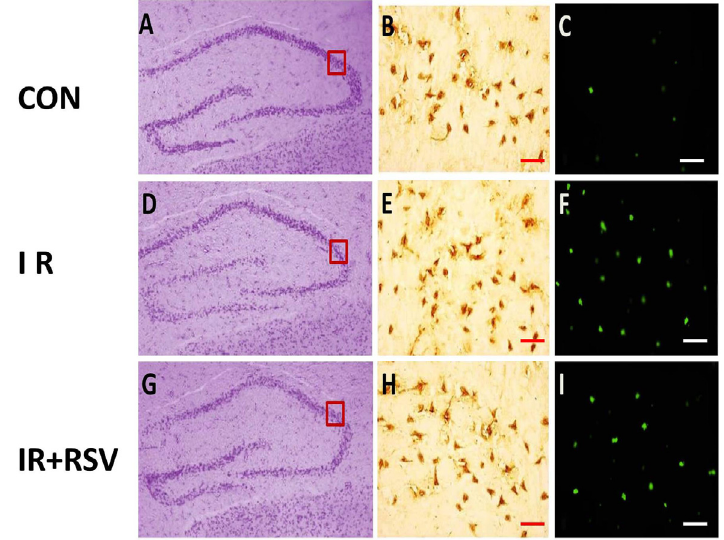
Figure 1. Representative micrographs of the hippocampal formation from coronal brain sections taken from rats of con group, IR group and IR + RSV group 24 h after